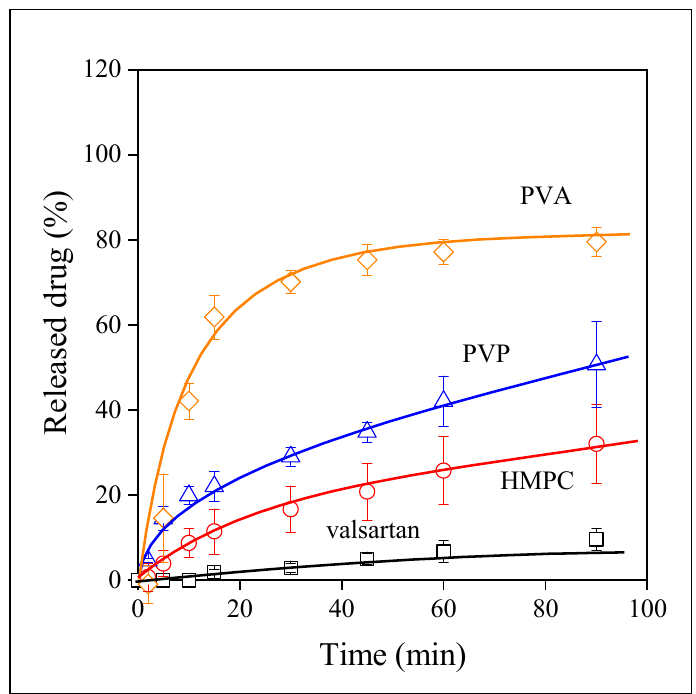
Figure 10. Comparison of the dissolution of valsartan and the kinetics of its release from the elec- trospun fibers produced from various water-soluble polymers at pH 1.2. Symbols: ( ) valsartan, ( ) HPMC, ( ) PVA, ( ) PVP.